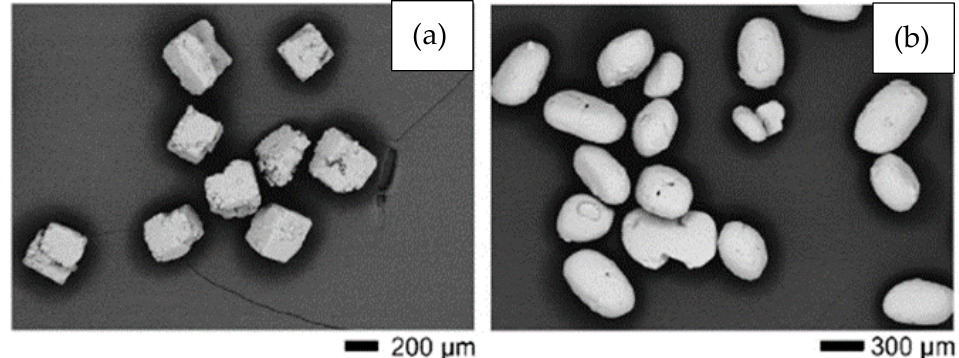
Figure 4. SEM images showing the morphology of ( a ) cubic NaCl and ( b ) rounded KCl powders used in experiments performed by Tuncer et al. Adapted and reproduced with permission [28]. Copyright 2014, Elsevier.